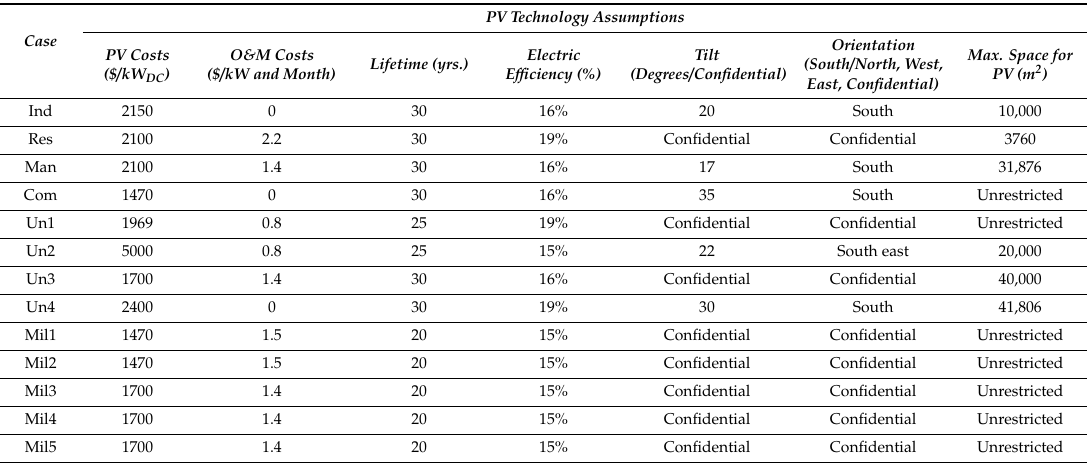
the maximum available onsite space for PV